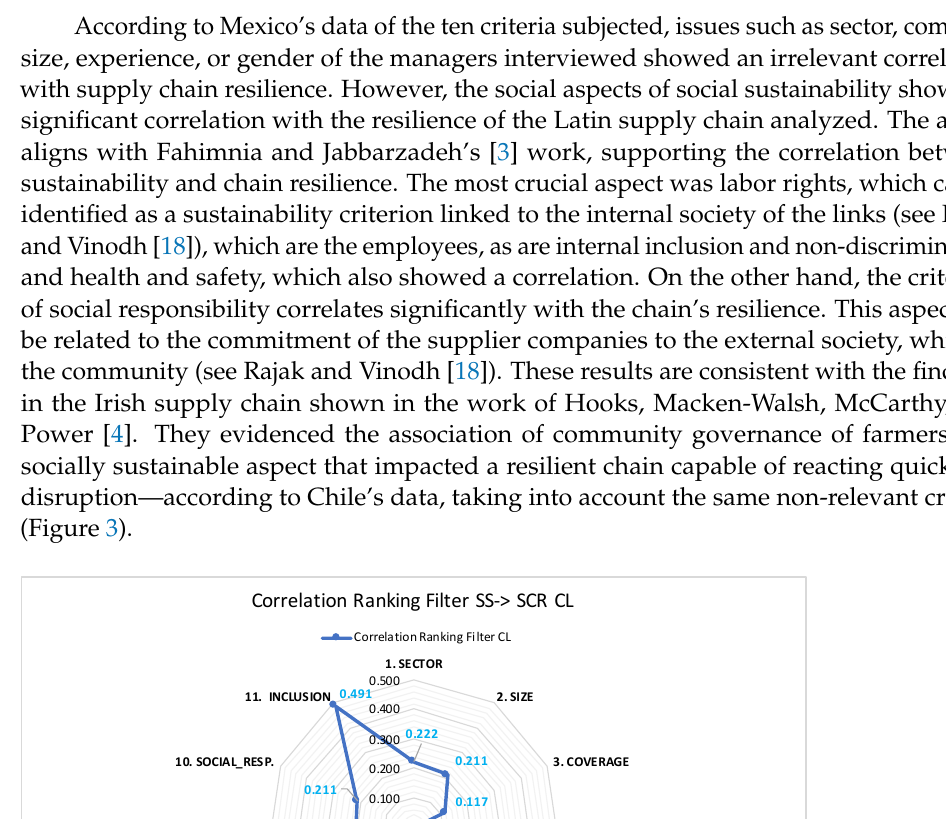
Figure 2. Ranking of the Pearson correlation coefficient for Mexico’s data.